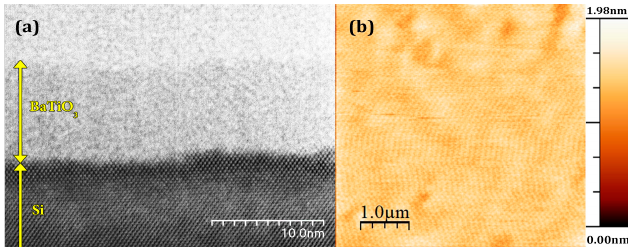
Figure 1. ( a ) Bright field STEM image of a 5.6 nm-thick BaTiO 3 film on Si substrate and ( b ) topography of the film before poling (RMS roughness 0.18 nm).